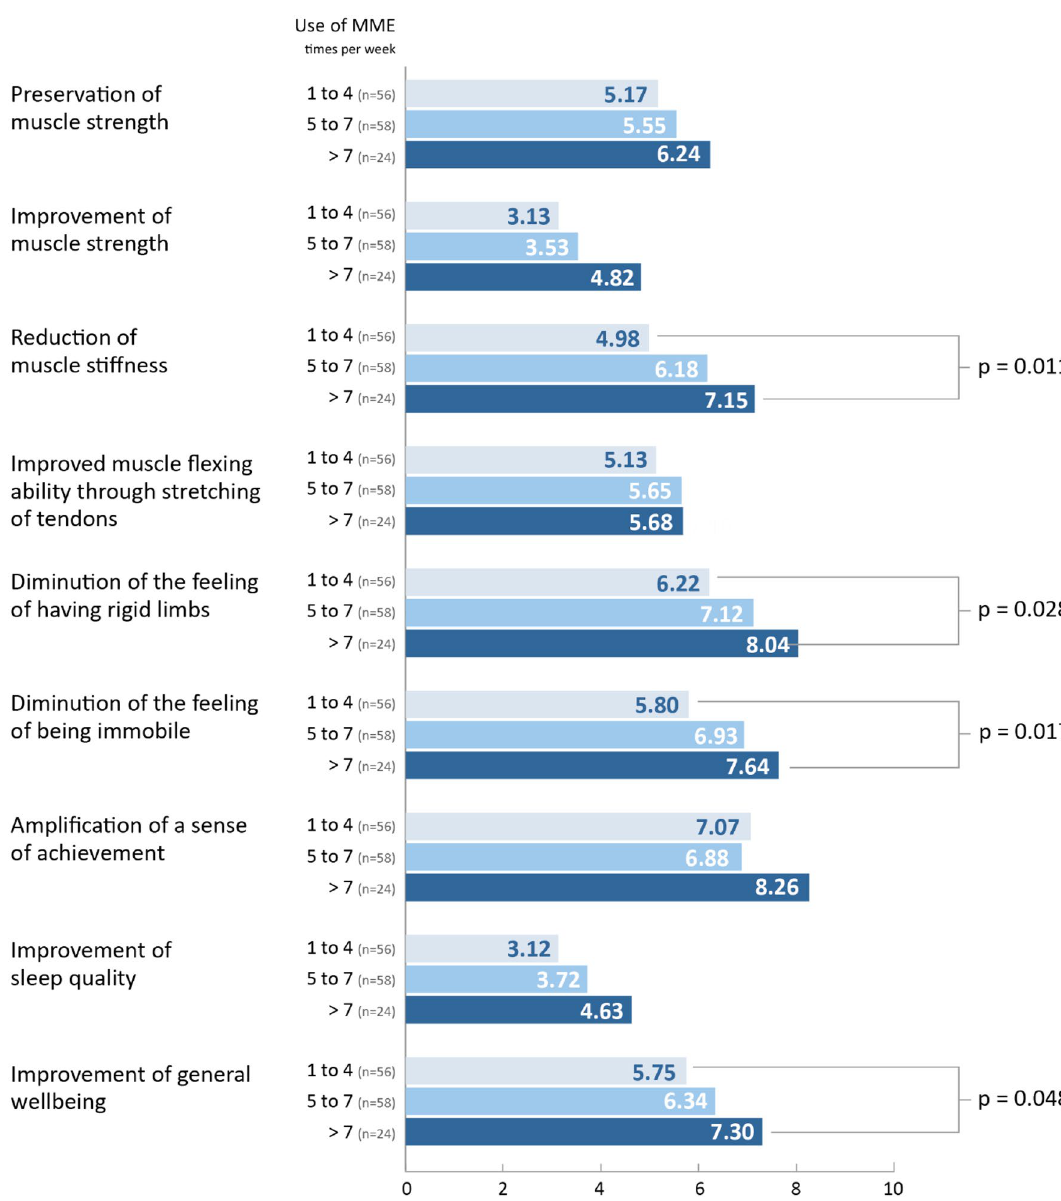
Figure 5. Domain-oriented participant experiences with respect to frequency of MME use. Domain-oriented participant experiences of MME were assessed on an 11-point Likert-scale ranging from 0 (no impact) to 10 (best possible impact). Different frequencies of MME use is depicted in the blue bars. Significant differences were assessed via the Kruskal–Wallis-Test. A p-value < 0.05 was considered significant. MME, motor-assisted movement exerciser; n, number of participants; n =